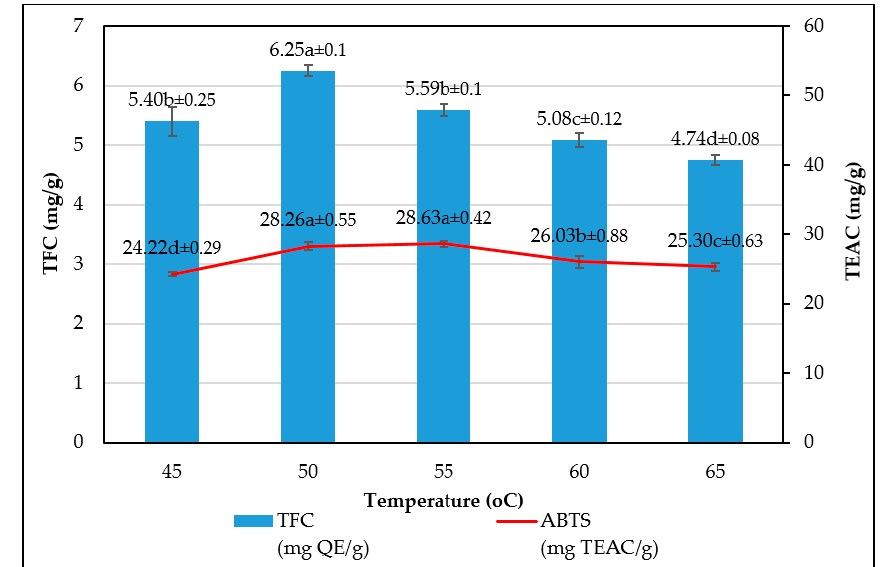
Figure 5. The effect of temperature to extraction process. Figure 5. The e ff ect of temperature to extraction process.